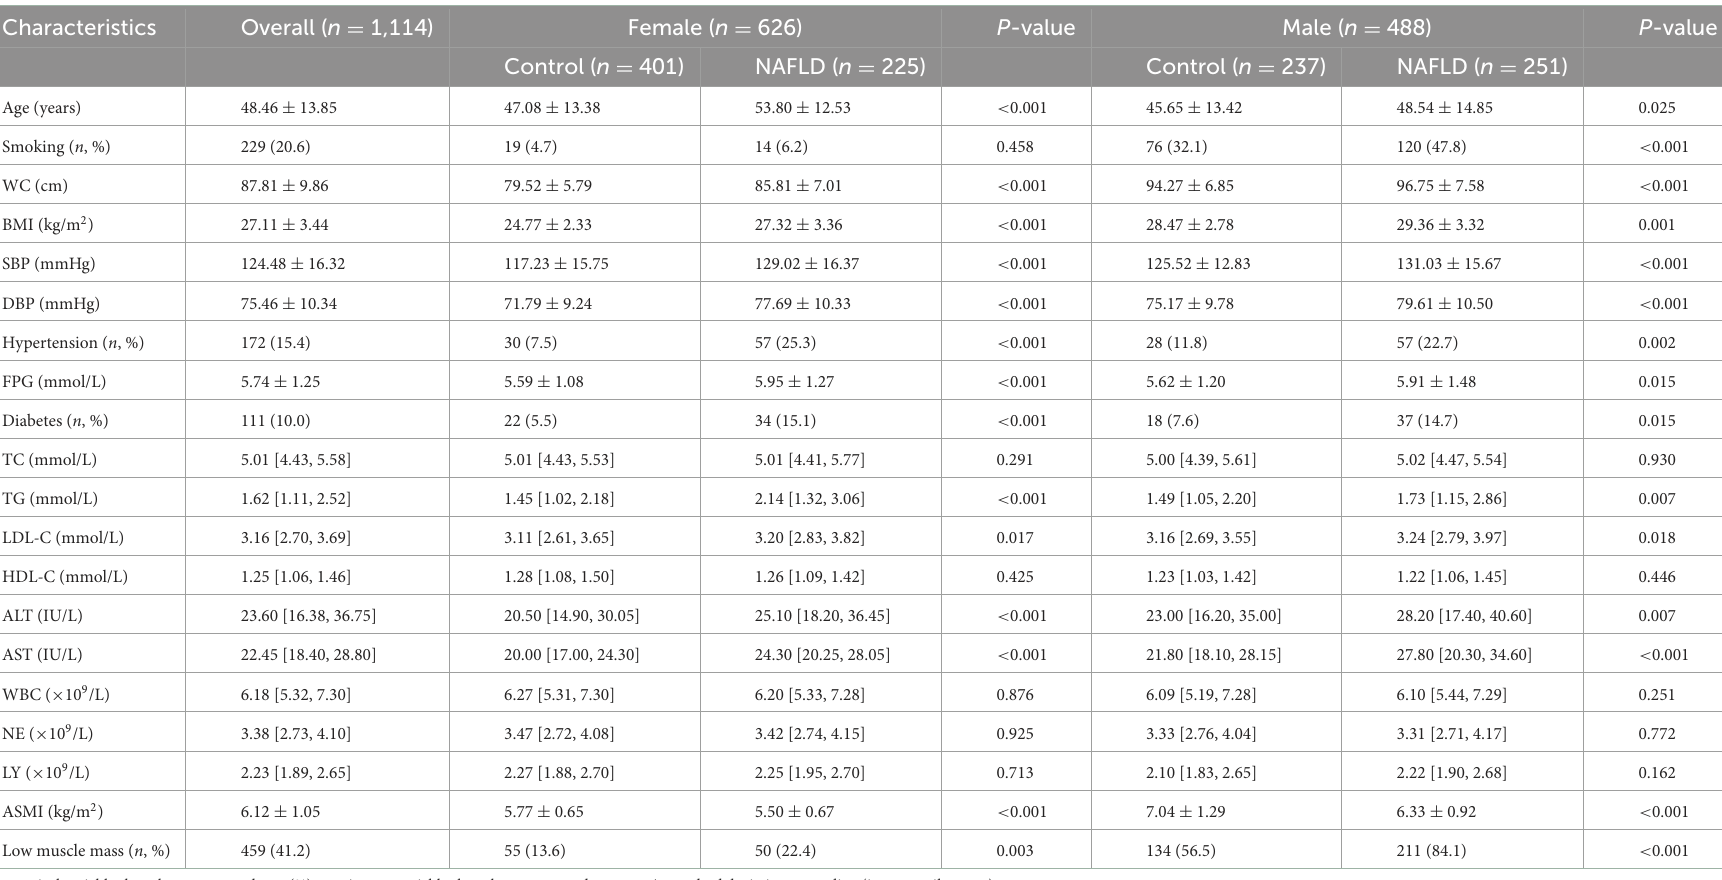
TABLE 1 Descriptive characteristics of participants with and without NAFLD, by gender ( n = 1,114).